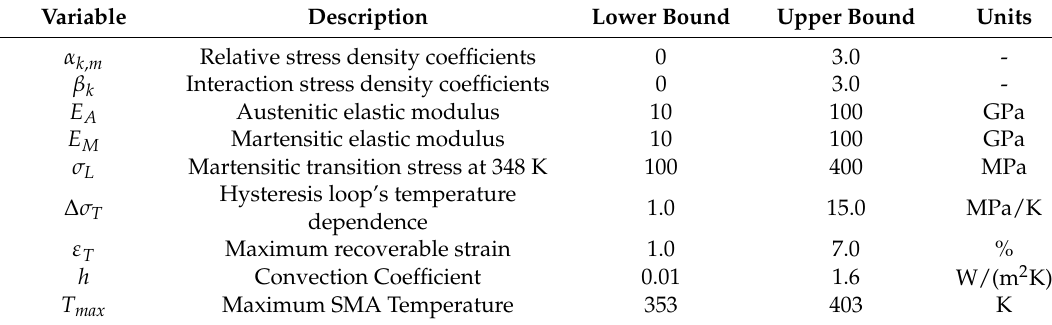
Table 1. Single-objective design variables and bounds.